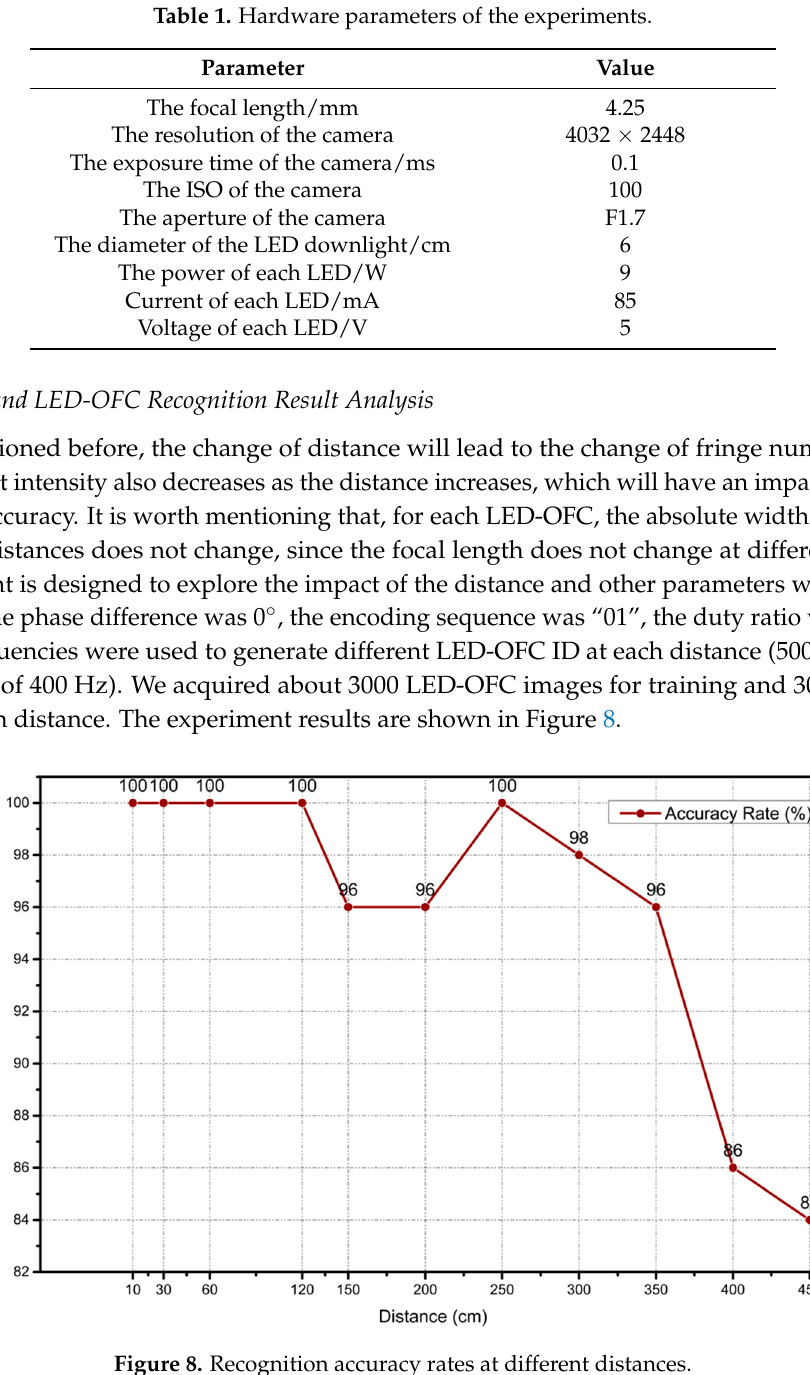
Figure 8. Recognition accuracy rates at different distances.